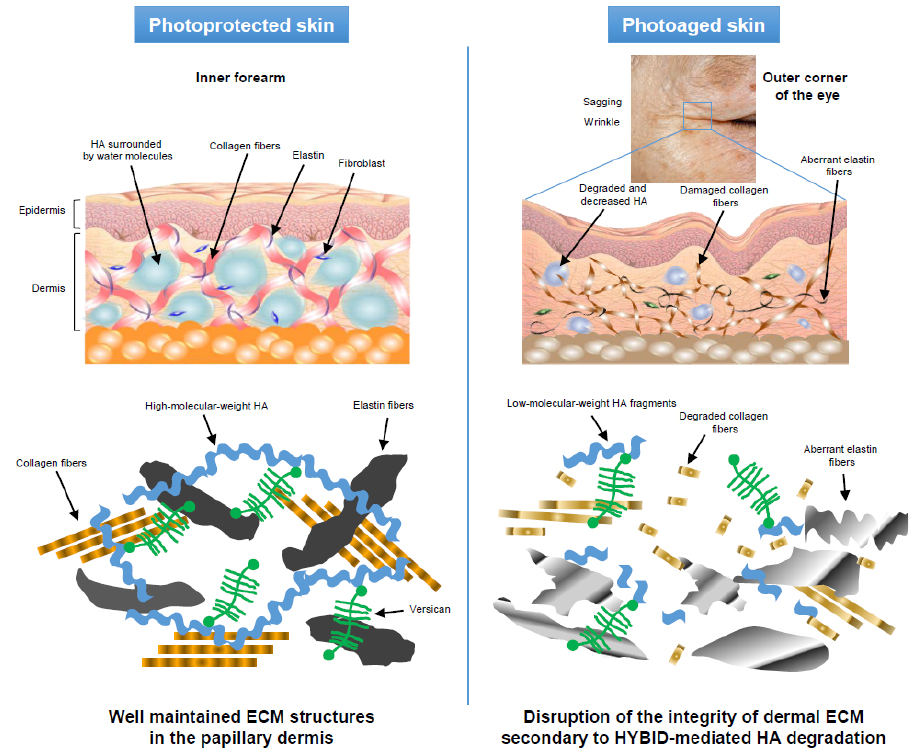
Figure 3. Overview of contribution of HYBID-mediated HA degradation and reduction in the papillary dermis to the photoaging skin symptoms. In the photoprotected skin (left panel), the integrity of the extracellular matrix (ECM) in the papillary dermis is well maintained, according to the balanced synthesis and degradation. HA is highly hydrophilic and surrounded with water molecules, producing a swelling pressure in the ECM and stabilizing skin structure. In the photoaged skin (right panel), HYBID-mediated HA degradation and reduction in the papillary dermis leads to reduced water binding properties and viscosity in the HA. This may contribute to disruption of the integrity of the dermal ECM by weakening the interaction with collagen and elastin fibers and promoting their degradation.